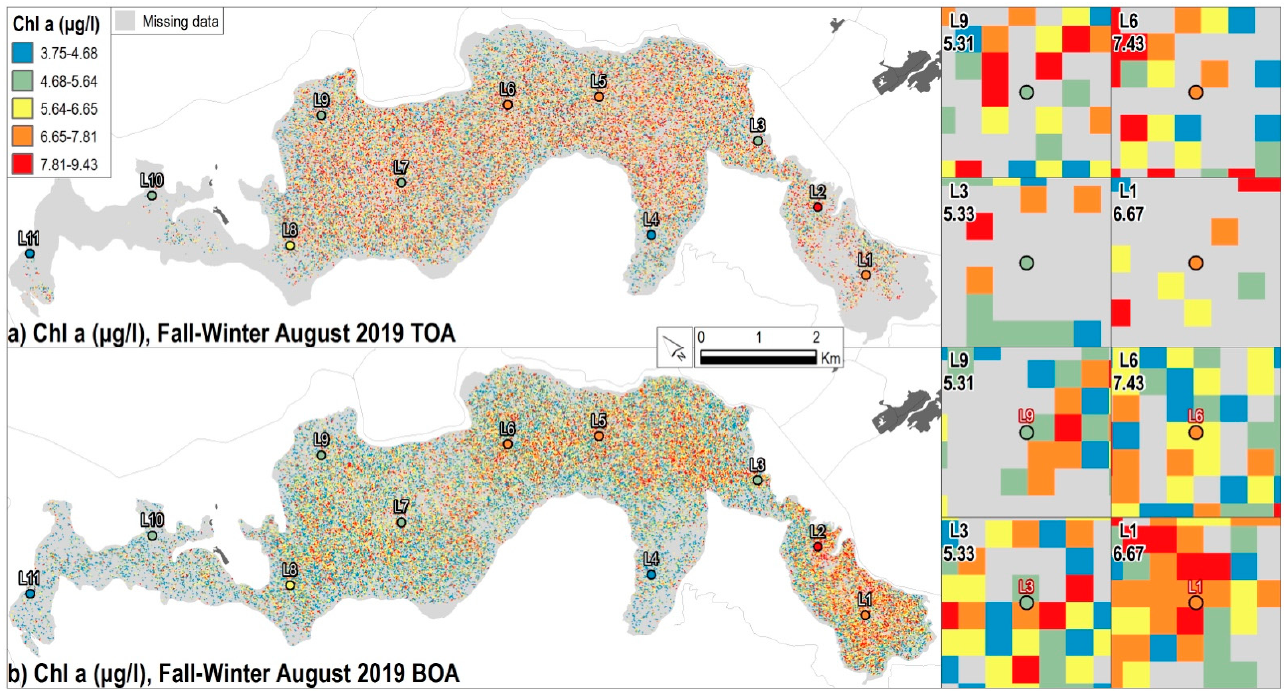
Figure 7. Chl-a concentration maps based on MLR for the fall-winter period: ( a ) made with TOA data (L1C) and ( b ) made with BOA data (L2A). On the right side of this figure, four Chl-a values of the samplings referred to as L6, L9, L3, and L1 are shown.